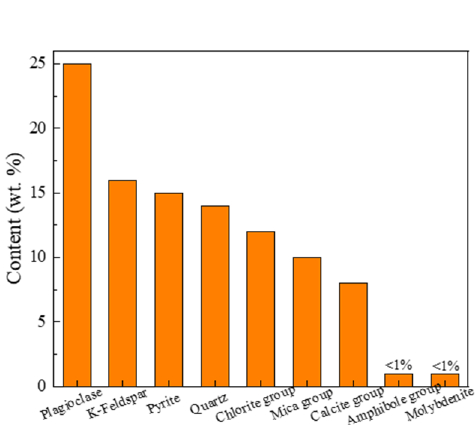
Figure 3. Composition of the feed samples used in present study.